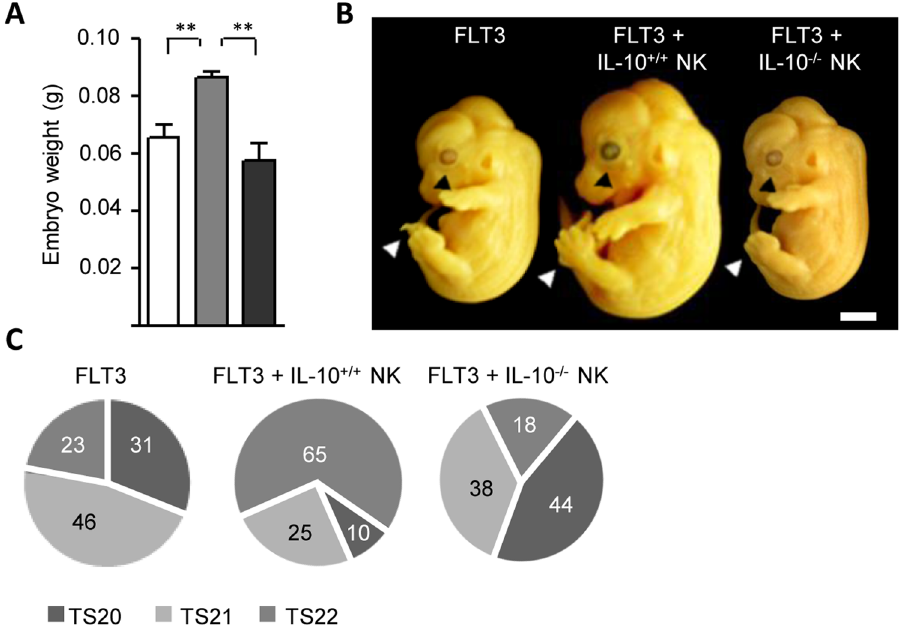
Figure 5. IL-10 + NK cells abrogate fetal growth restriction in FLT3 treated IL-10 − / − mice. ( A ) Mean body weights registered in the offspring following FLT3 treatment in IL-10 − / − female mice with or without IL-10 + / + NK cells adoptive transfer during early pregnancy. Data shown are mean ± SEM derived from 25–30 fetuses per group. ( B ) Representative images of fetuses obtained on ED13.5 from FLT3 treated IL-10 − / − female mice with IL-10 + / + or IL-10 − / − NK cells adoptive transfer; Bar = 0.25 cm. White arrows denote separated fingers on the toes and black arrows indicate the visible hair follicles. ( C ) Distribution of Theiler stage (TS) of fetal development on ED13.5. Twenty five to thirty fetuses derived from FLT3 treated in IL-10 − / − female mice with IL-10 + / + or IL-10 − / − NK cells adoptive transfer were scored. The distribution of TS is shown using a pie chart. The percentages of fetuses corresponded to TS20, TS21 and TS22 are indicated for each pie slice. ** p < 0.01 analyzed by the Tukey’s